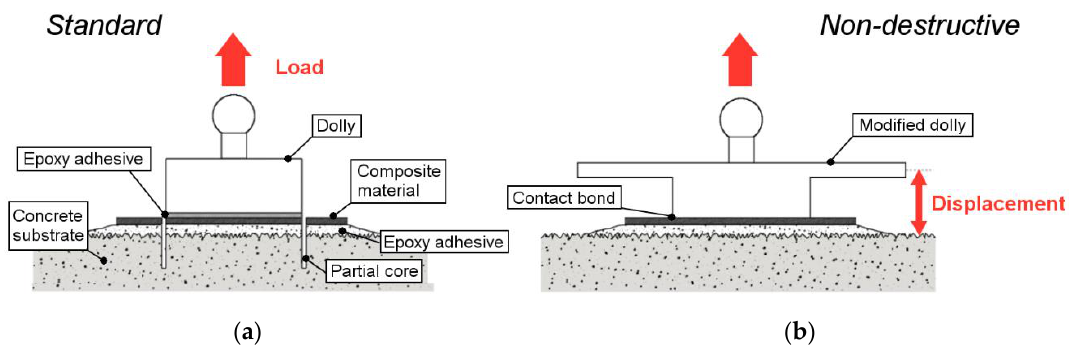
Figure 2. ( a ) Operating principle of the standard pull-off test and ( b ) operating principle of the modified ND pull-off test.